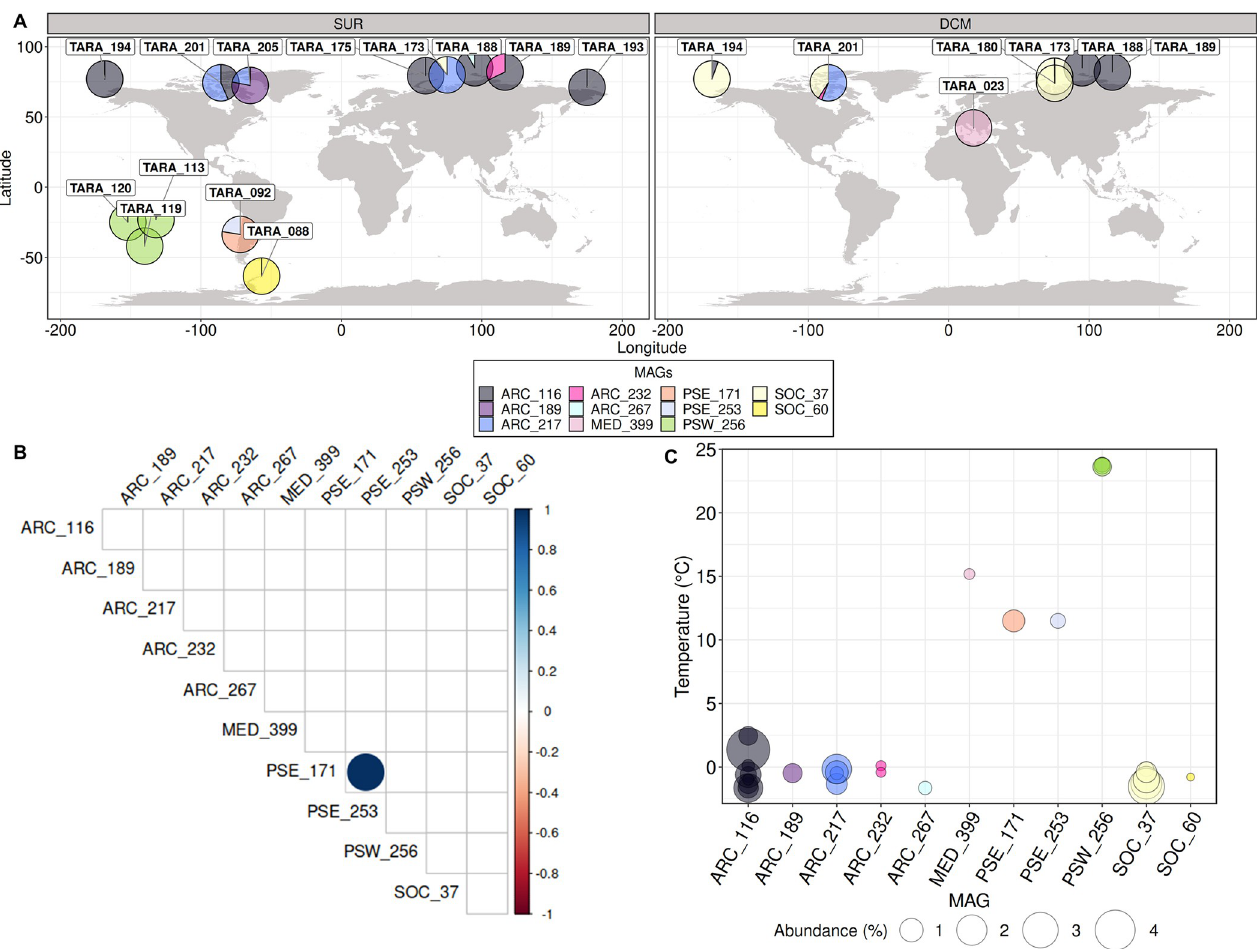
Fig 4. Biogeography of the Chaetoceros MAGs throughout Tara Oceans sampling sites. (A) Relative contributions of the Chaetoceros MAGs in SUR and DCM depths (see Tables A and B in S4 Table for details). The basemap was generated from the Natural Earth data (http://www.naturalearthdata.com/ downloads/50m-physical-vectors/); Natural Earth—All maps are public domain (http://www.naturalearthdata.com/about/terms-of-use/). (B) Pairwise correlation patterns of the MAG relative abundances across Tara Oceans stations (the colour bar represents Spearman’s correlation rho ; values are shown when p -value is inferior to 0.05). (C) Bubble plot corresponding to the measured temperature at the sampling stations where each MAG was detected. DCM, deep- chlorophyll maximum; MAG, metagenome-assembled genome; SUR, surface.